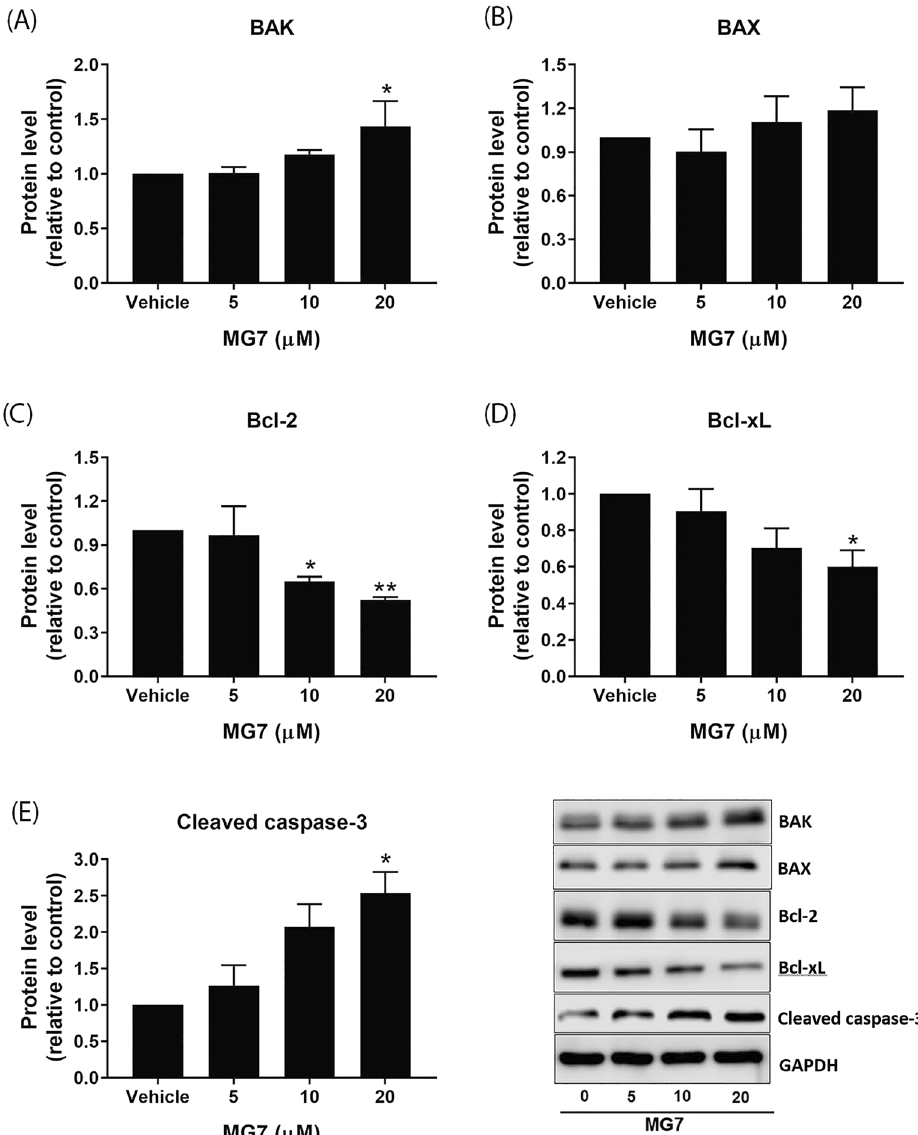
Figure 6. Effects of MG7 on the protein expression of Bcl-2 family members in HT29 cells. The cells were treated with MG7 at concentrations of 5, 10 and 20 µM for 24 h. The expression levels of ( A ) BAK, ( B ) BAX, ( C ) Bcl-2, ( D ) Bcl-xL and ( E ) cleaved caspase-3 proteins were determined using western blot. Data are expressed as mean ± SEM of three independent experiments. * P < 0.05 and ** P < 0.01 compared to vehicle control (0.2%